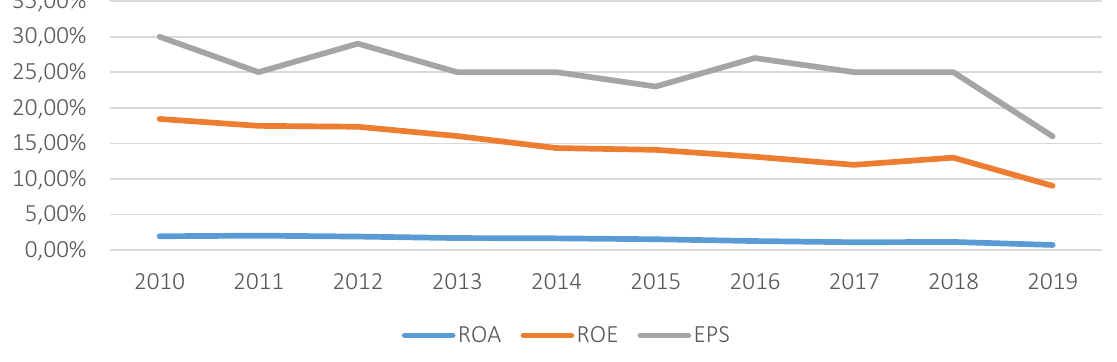
Figure 3. Financial performance indicators of the Bank of Palestine during the period